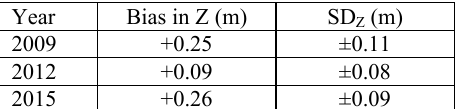
Table 3. Bundle adjustment with Agisoft PhotoScan (stereopair M2-R, idealized image data).